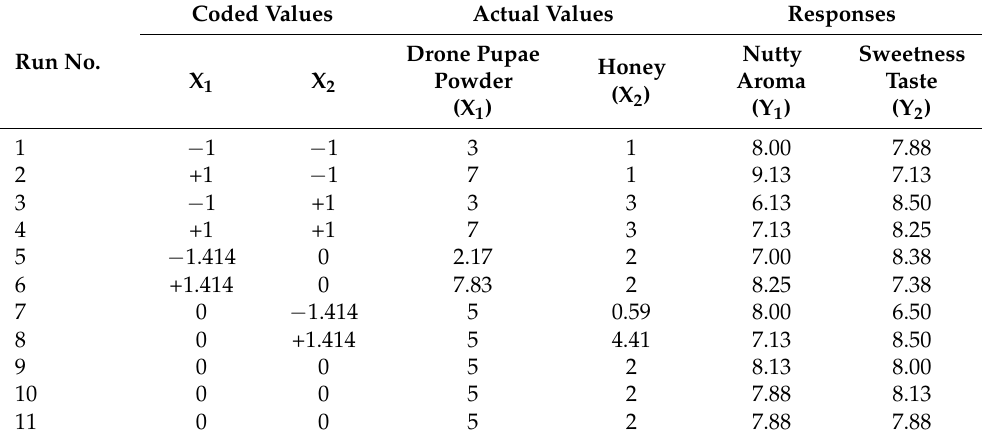
Table 10. Experimental results for central composite design.